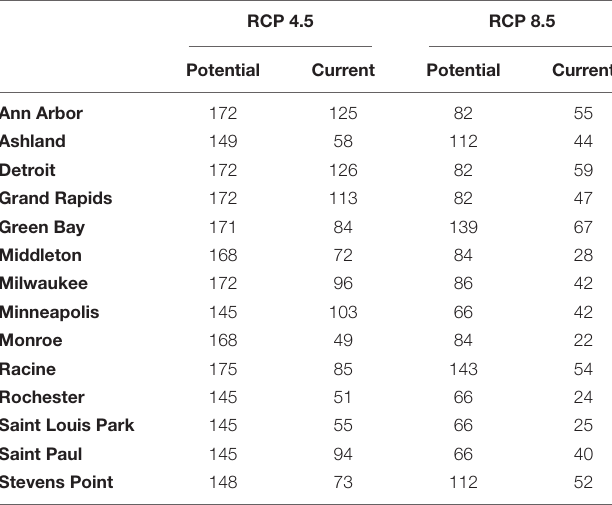
TABLE 4 | Number of species that are considered suitable for planting based on current and projected hardiness and heat zones in each